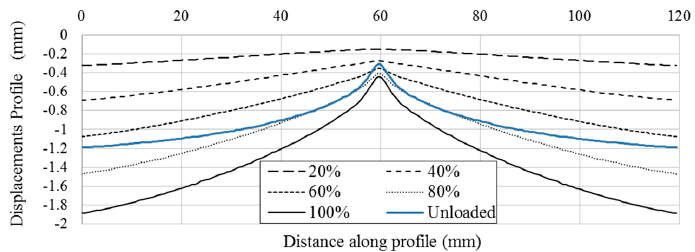
Figure 13. Evolution of the out of plane displacements along the profile AA’ (defined in Figure 10a) at different displacement steps (in percentage) during the loading and unloading final step for a 6 mm-thick specimen.